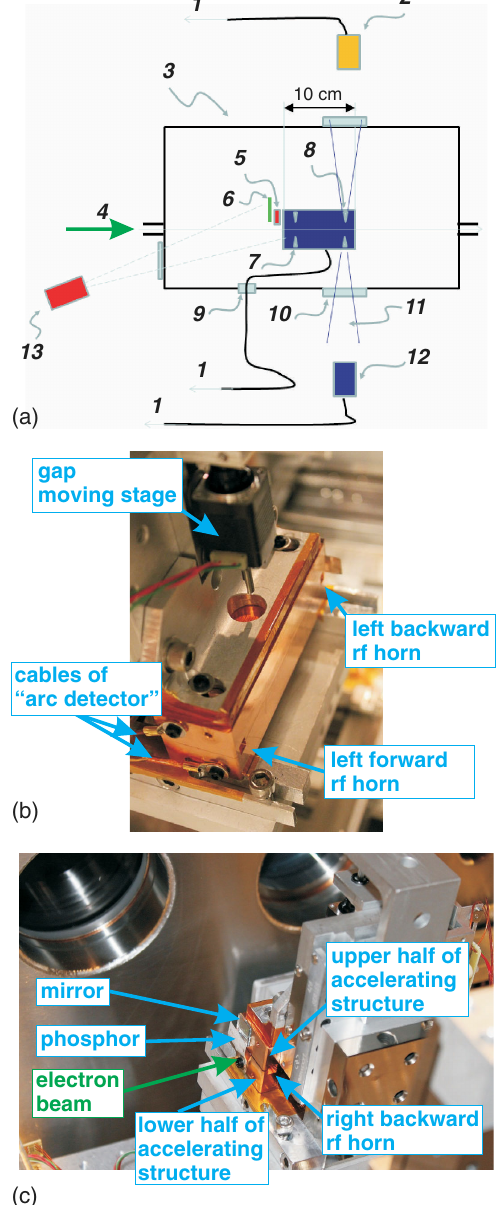
FIG. 12. Schematic of the experimental setup (a): signal to scope (1), interferometer (2), vacuum chamber (3), electron beam (4), laser alignment mirror (5), phosphor screen (6), right reflected rf horn (7), left forward rf horn (8), vacuum feedthrough (9), rf window (10), output rf beam (11), pyrodetector (12), and video camera for beam-structure alignment and rf breakdown diagnostic (13). The accelerating structure was assembled on remotely controlled motorized stages, with the arc-detector cables connected (b). The accelerating structure was installed in the vacuum chamber